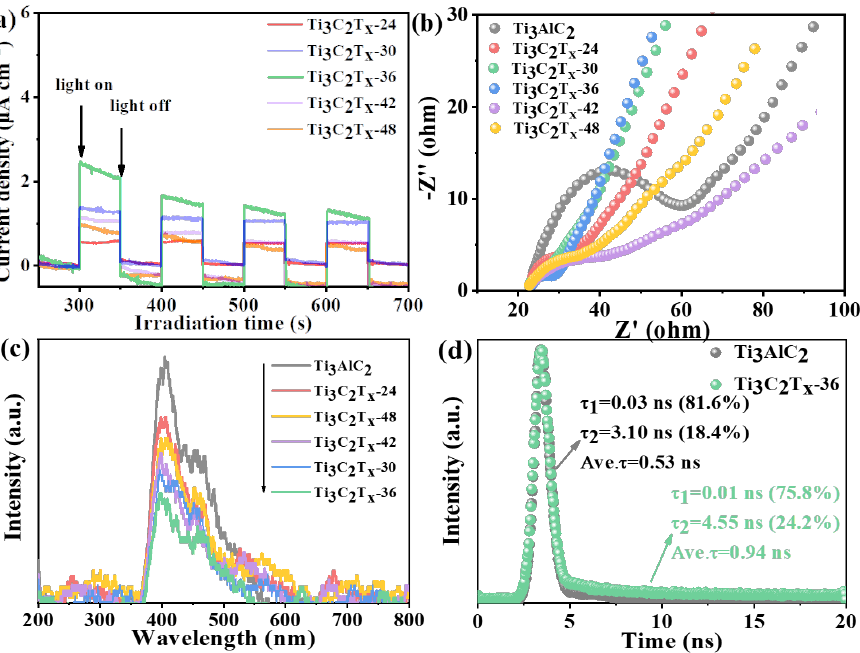
Figure 3. ( a ) Transient photocurrent responses, ( b ) EIS Nyquist plots, ( c ) PL spectra and ( d ) TRPL decay spectra of prepared photocatalysts.